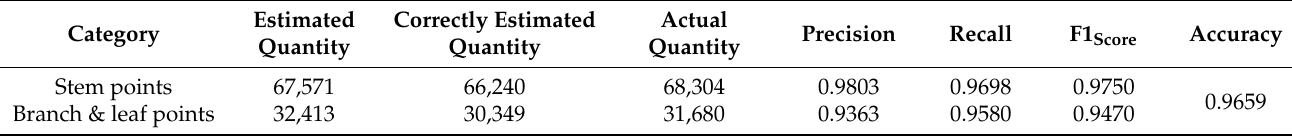
Table 3. Classification accuracy index of the training